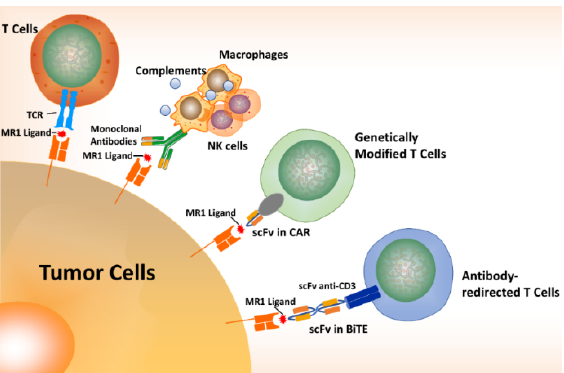
Figure 4. MR1-dependent strategies for cancer treatment. There are at least four routes to targeting MR1-expressing tumor cells. (1) MR1-mediated tumor cell lysis is mediated by the recognition of MR1-ligand by a TCR. (2) An antibody targeting MR1-ligand induces phagocytosis and complements activation and antibody-dependent cellular cytotoxicity (ADCC). (3) The scFv of above antibody is engineered into CAR T cells. (4) BiTE redirected-T cells have two scFvs to recognize both CD3 + T cells and